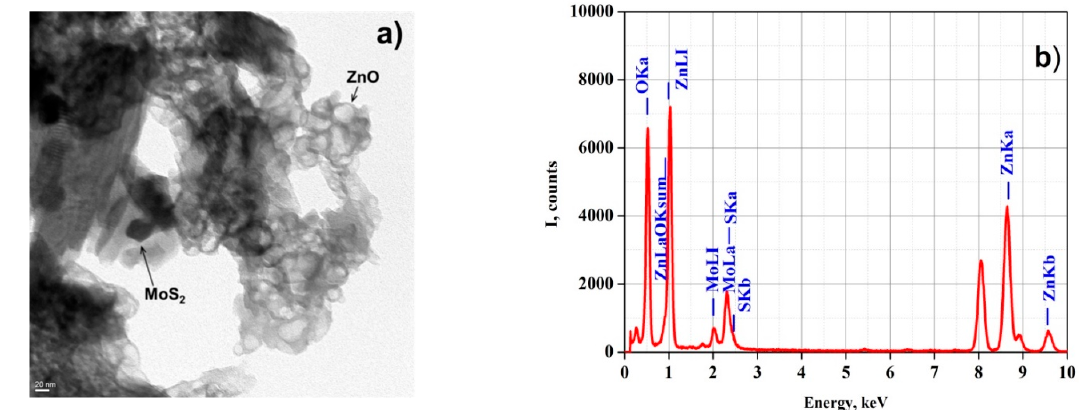
Figure 4. Transmission electron microscopy (TEM) image (magnification of 500,000 × ) ( a ) and energy-dispersive X-ray (EDS) spectrum ( b ) of the prepared MoS 2 @ZnO nanoheterostructures.